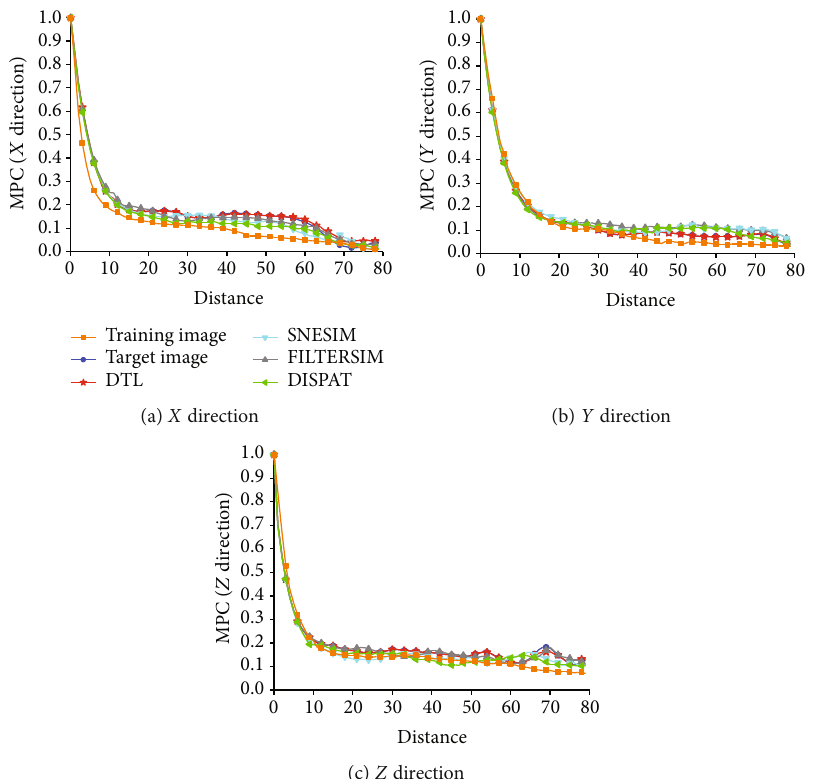
Figure 24: MPC curves of reconstructed sandstone images by 5% conditioning data using SNESIM, FILTERSIM, DISPAT, and DTL in three